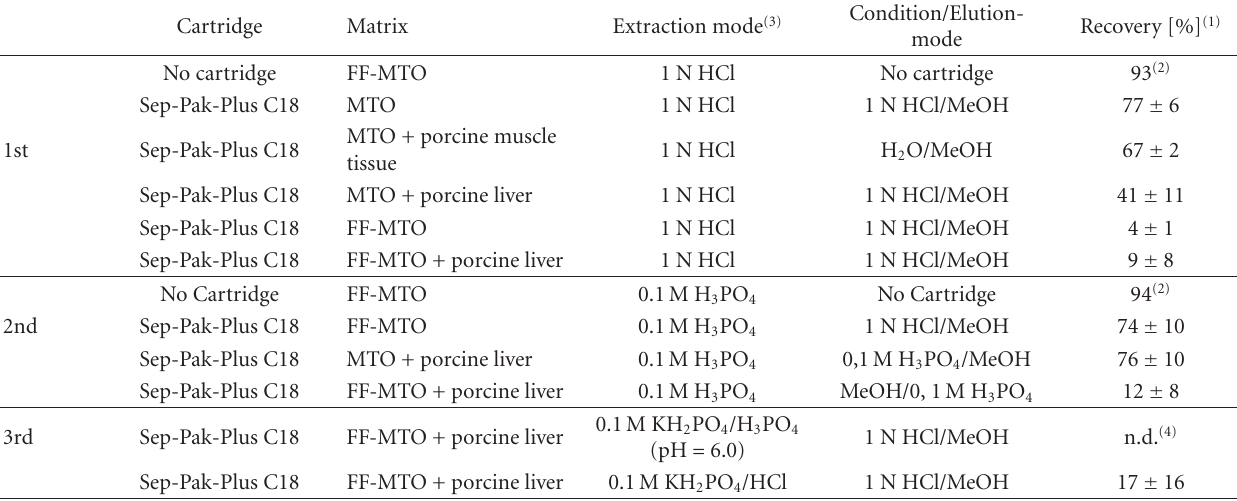
Table 3: Mitoxantrone (MTO) recovery of pure MTO or MTO bound to ferrofluid (FF) in 2.5g tissue using a RP-18-Cartridge. 1st section shows extractants based on hydrochloric acid, 2nd section shows phosphoric acid-based extractants, and 3rd section shows phosphate-bu ff